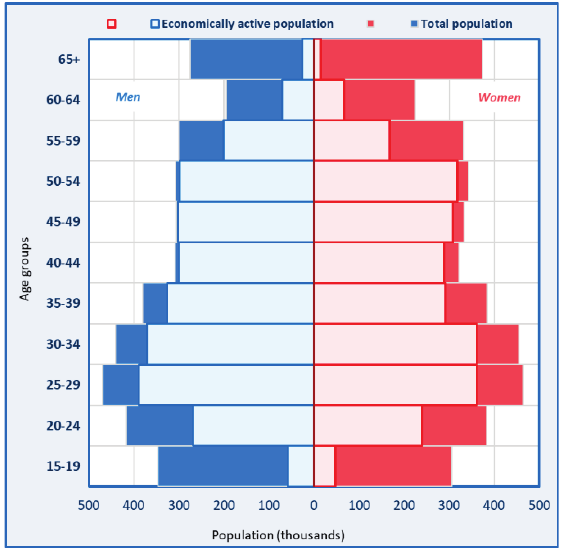
Figure 26. The age structure of labour resources in Azerbaijan, 1990-2018 (beginning of the year). Source: according to SSC data.